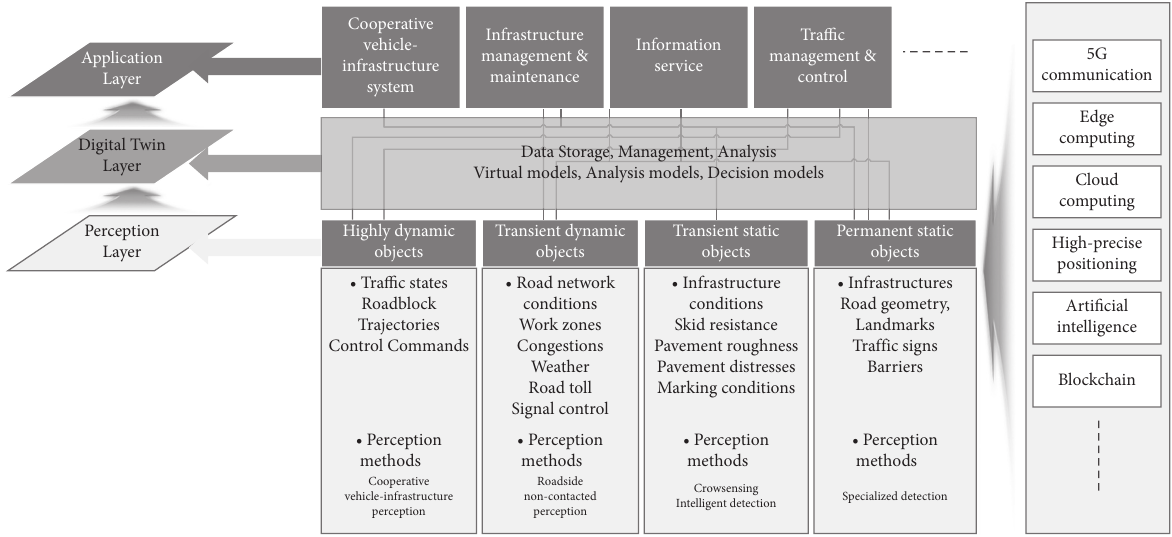
Figure 6: Physical architecture of the Table 2: Data requirements of the NGSH for different applications.